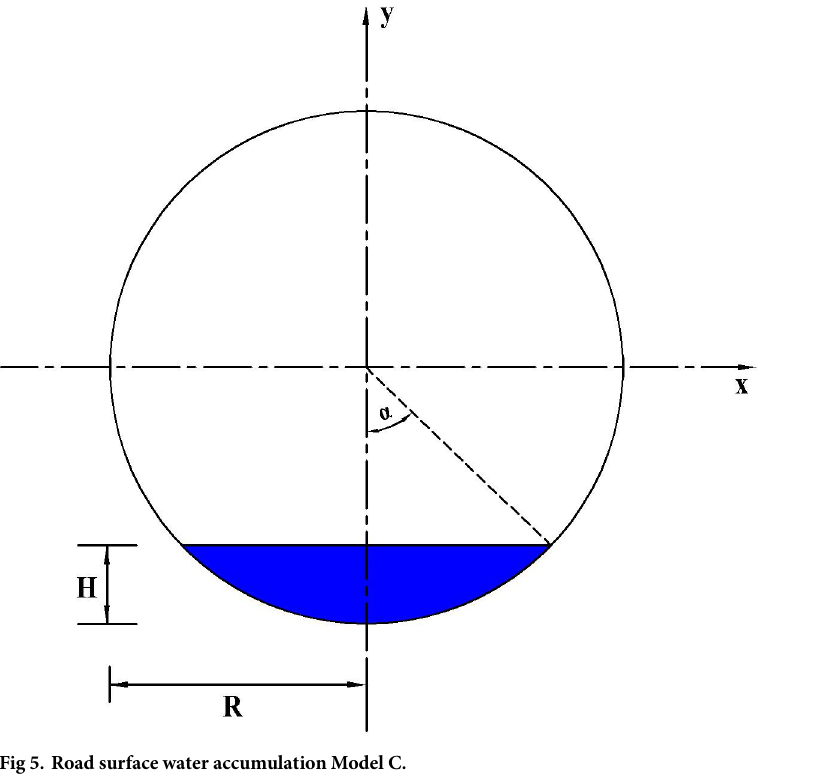
Fig 5. Road surface water accumulation Model